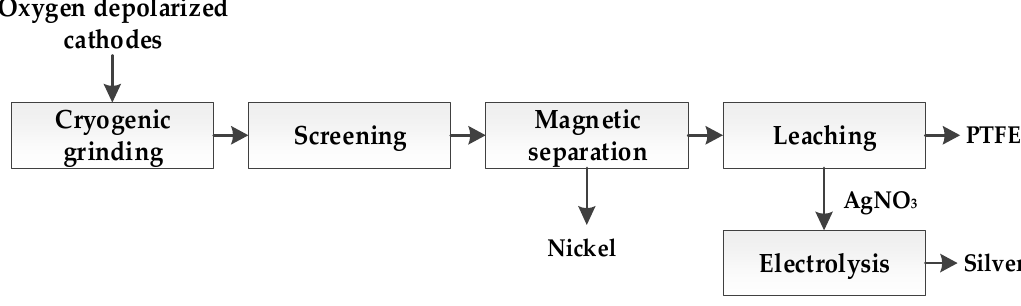
Figure 1. Schematic procedure for recycling silver from oxygen ‐ depolarized cathodes (ODCs). As shown in the flow sheet for the developed recycling process, the main objective was to devise